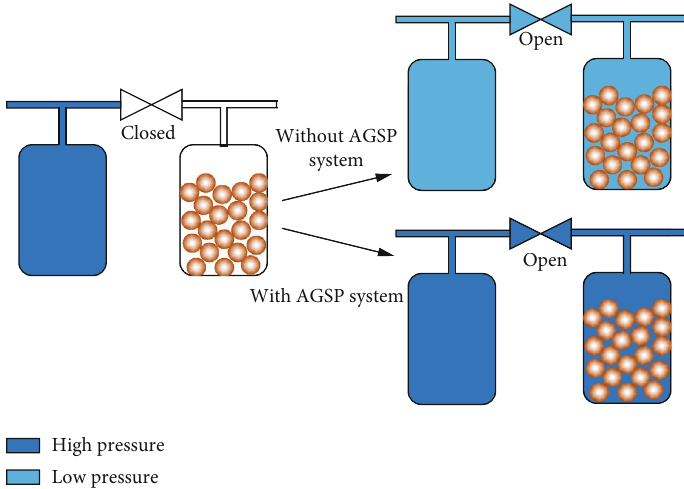
Figure 2: The function of AGSP system in the